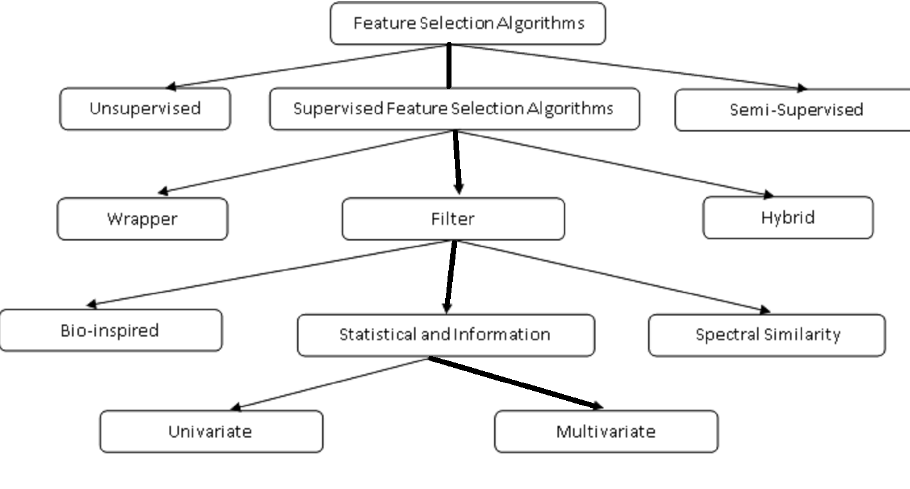
Figure 1. The Taxonomy of Features Selection